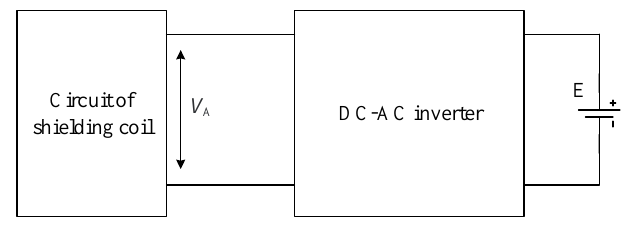
Figure 5. Circuit design of active shielding system.